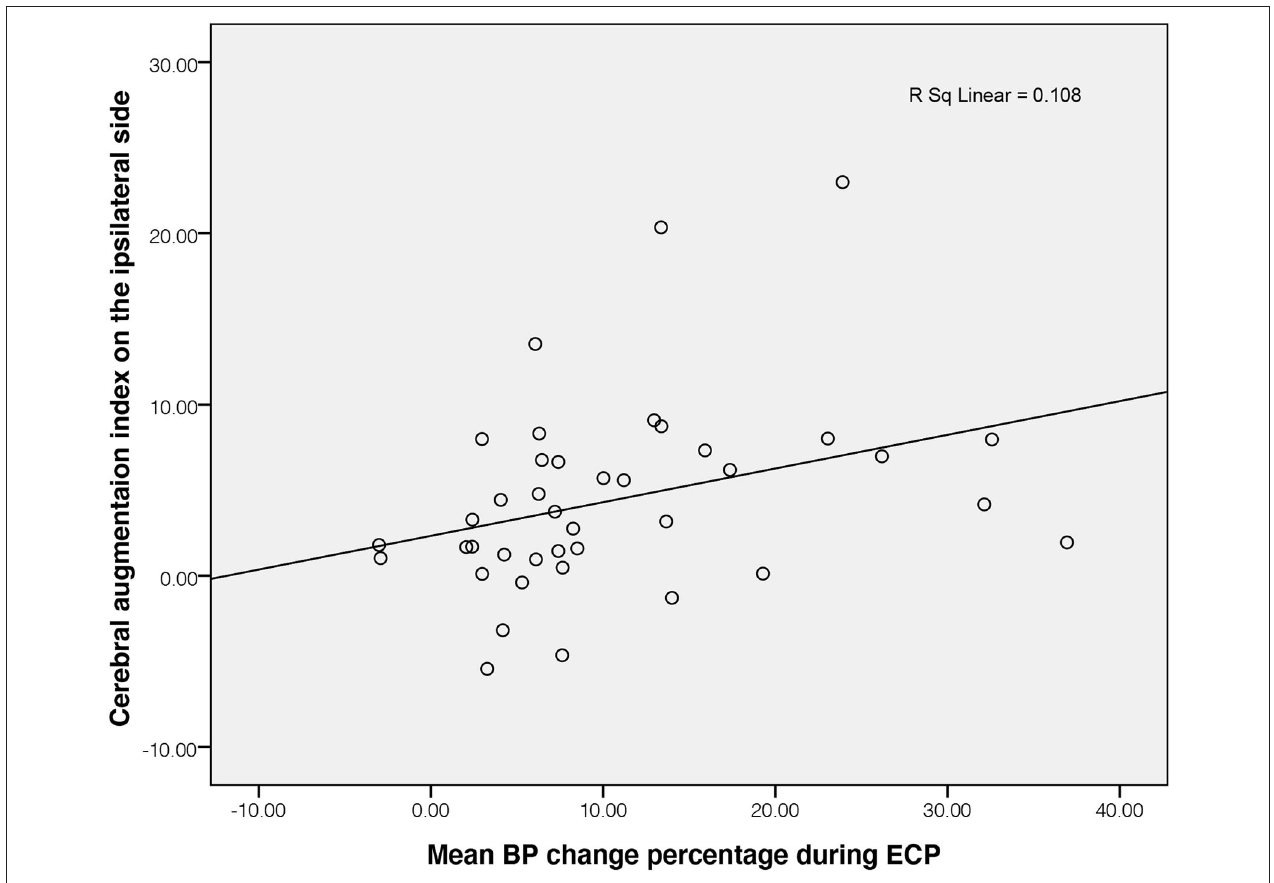
FIGURE 1 | Correlation of BP change and ipsilateral cerebral augmentation index in patients with stroke. BP, blood pressure; ECP, external counterpulsation.